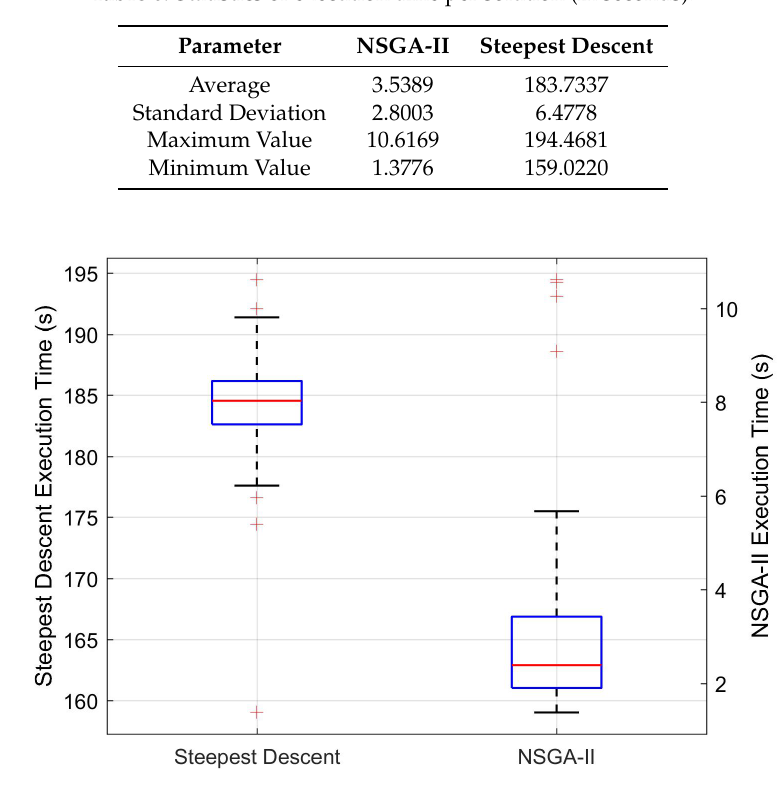
Figure 14. Boxplot of the execution time